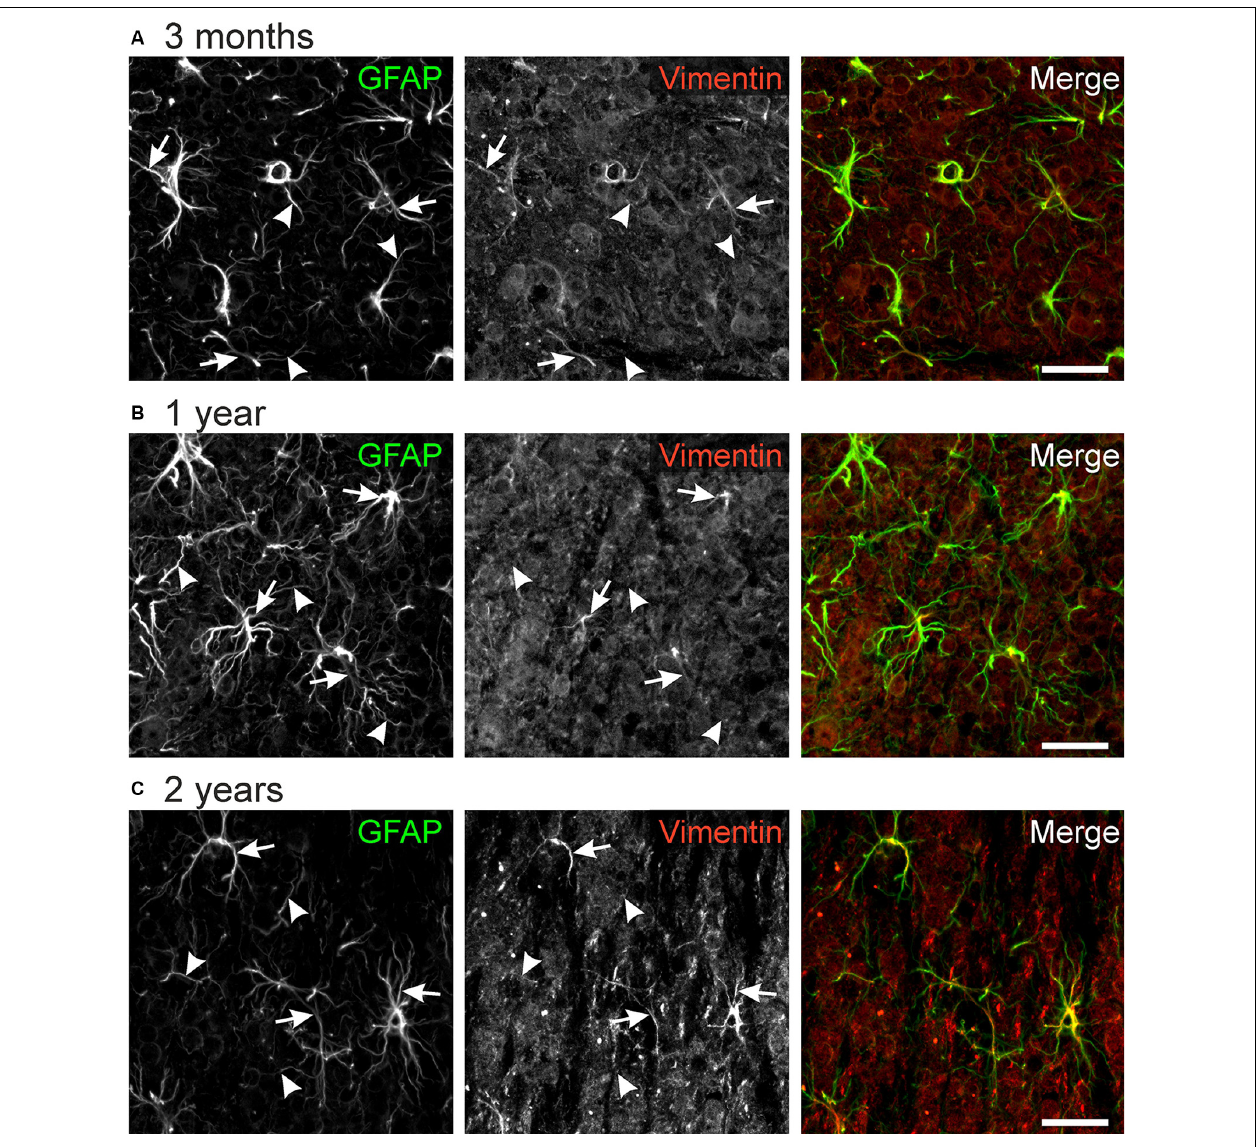
FIGURE 5 | GFAP-vimentin colocalization in the mouse olfactory bulb. Anti-GFAP (green) and anti-vimentin (red) immunoreactivity colocalizes in some astrocyte processes (arrows), while most GFAP-positive processes were vimentin-negative (arrowheads). This result was observed in mice of the age of 3 months (A) , 1 year (B) , and 2 years (C) . Scale bar: 20 µ